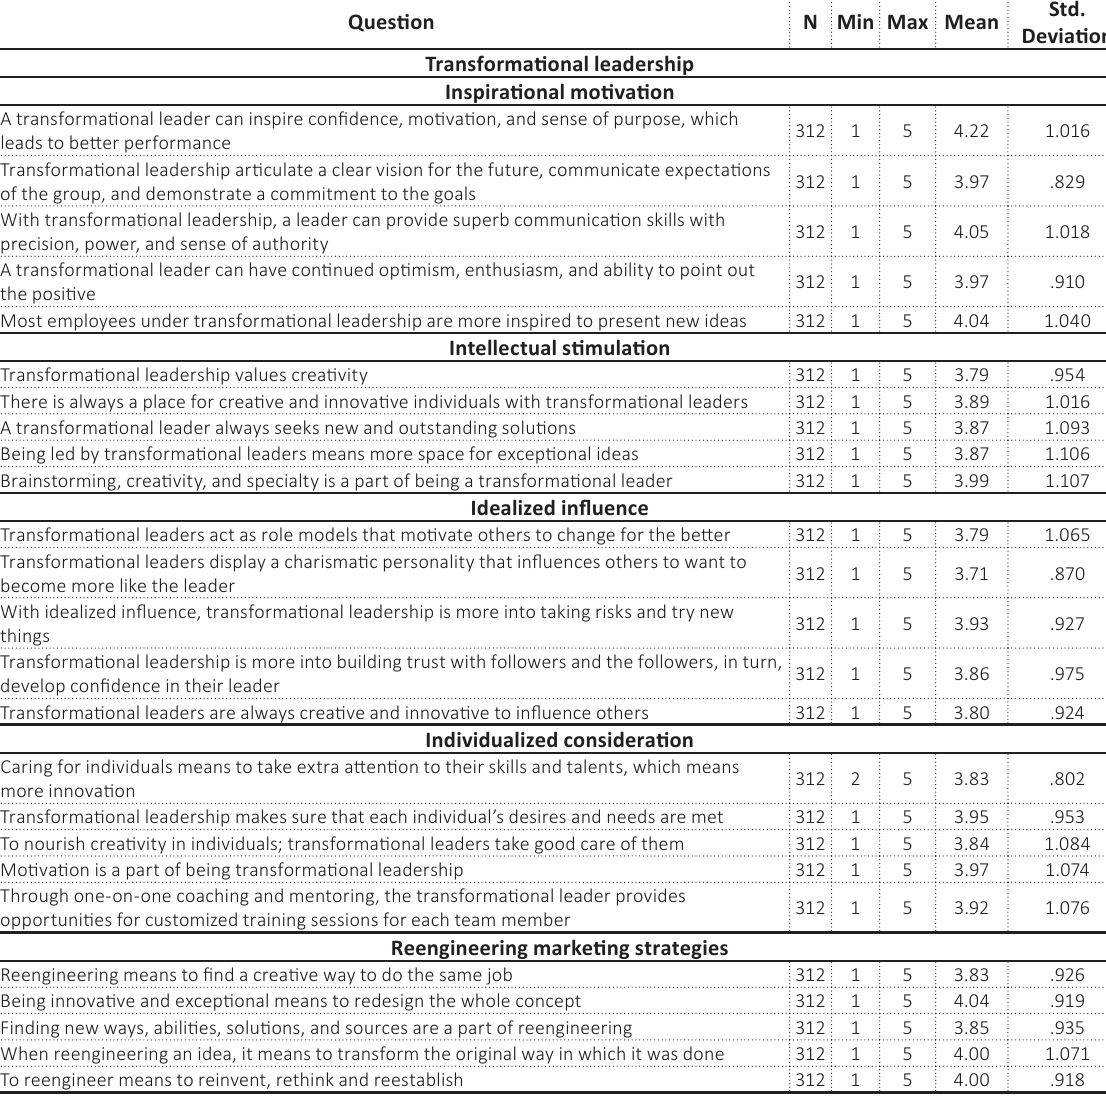
Table 4. Questionnaire